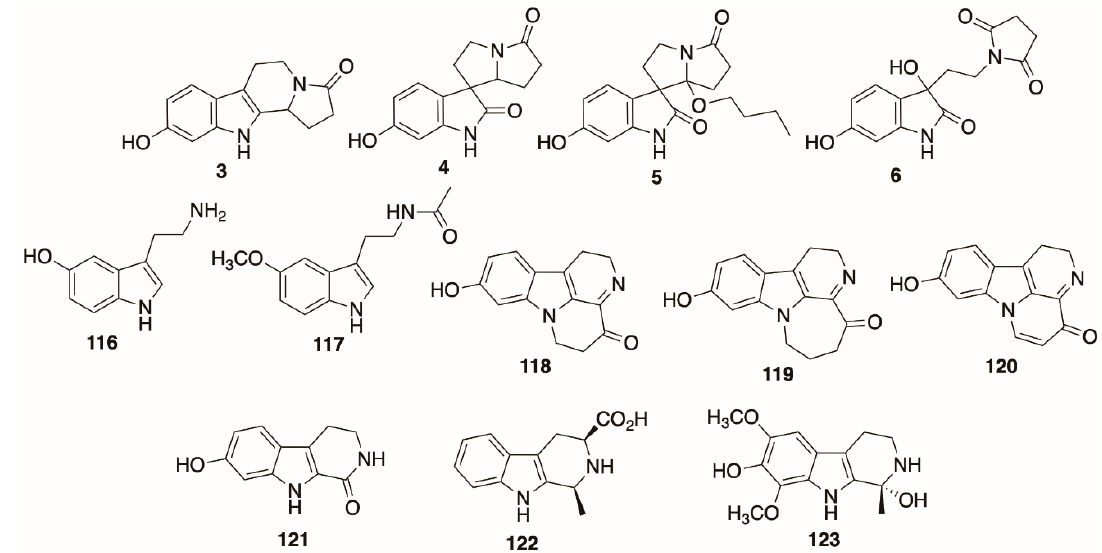
Figure 12. Indole and beta -carboline alkaloids found in D. stramonium and D. metel . While daturametelindoles B-D are oxindoles, daturametelindole A ( 3 ) appears to be (2009) found the hydroxytryptamine serotonin ( 116 ) along with melatonin ( 117 ) in the flowers and buds of D. metel var. fastuosa . Interestingly, the compounds were most